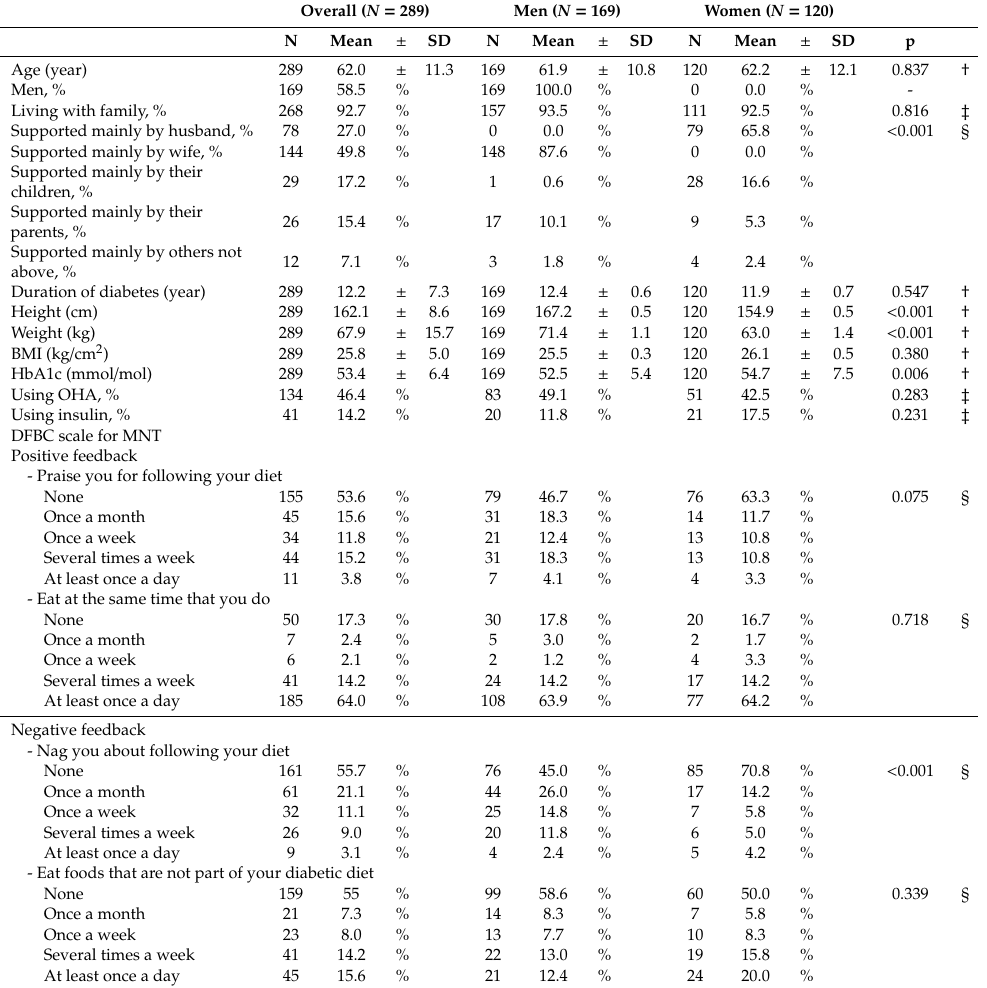
Table 1. Characteristics of study